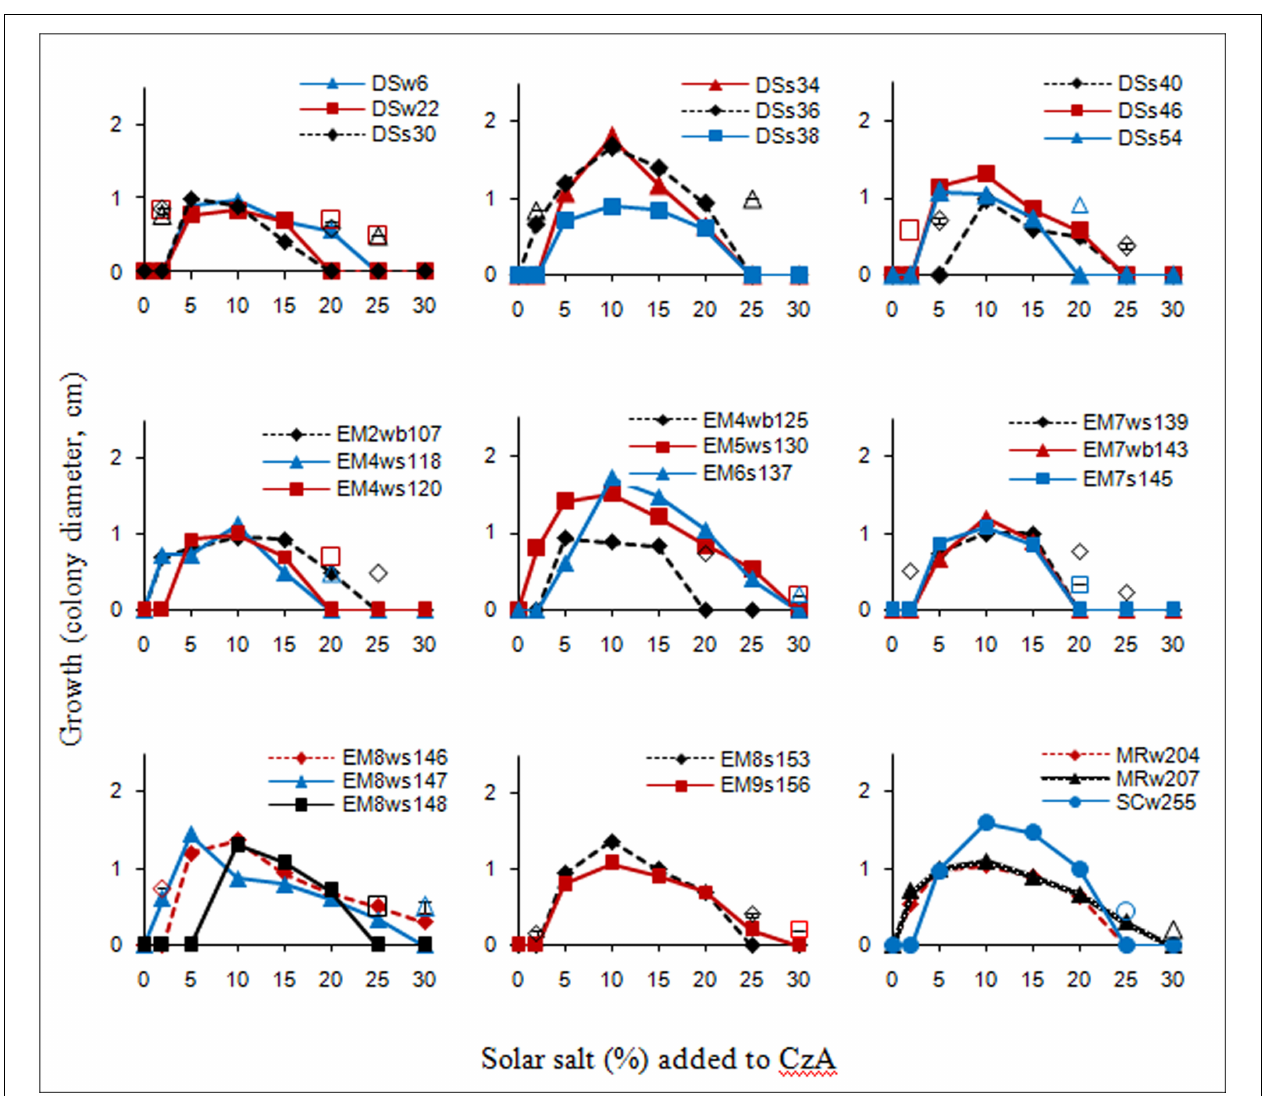
FIGURE 1 | Salt tolerance curves of the isolates as recorded after 7 d incubation; unconnected open symbols indicate delayed growth at respective salt concentrations, after 15 d